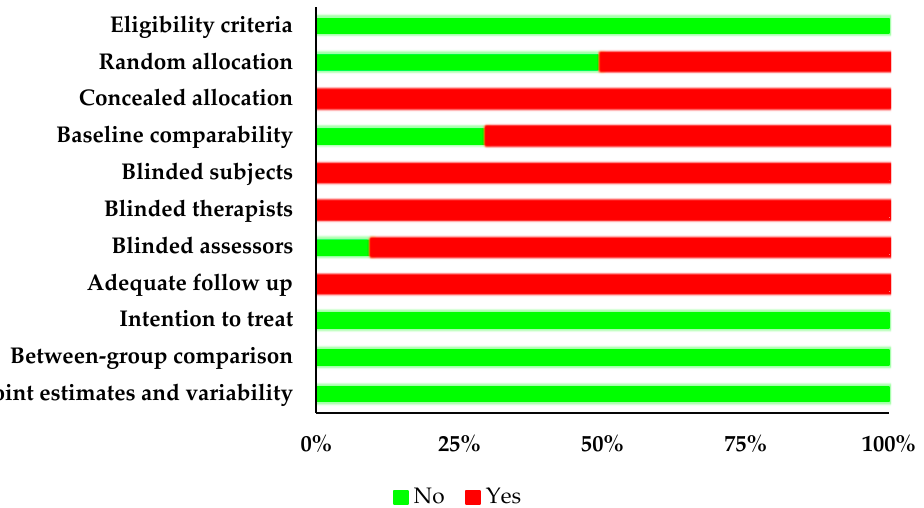
Figure 2. Risk of bias based on the PEDro scale (“No” indicates the absence of risk of bias and “Yes” indicates the presence of risk of bias).